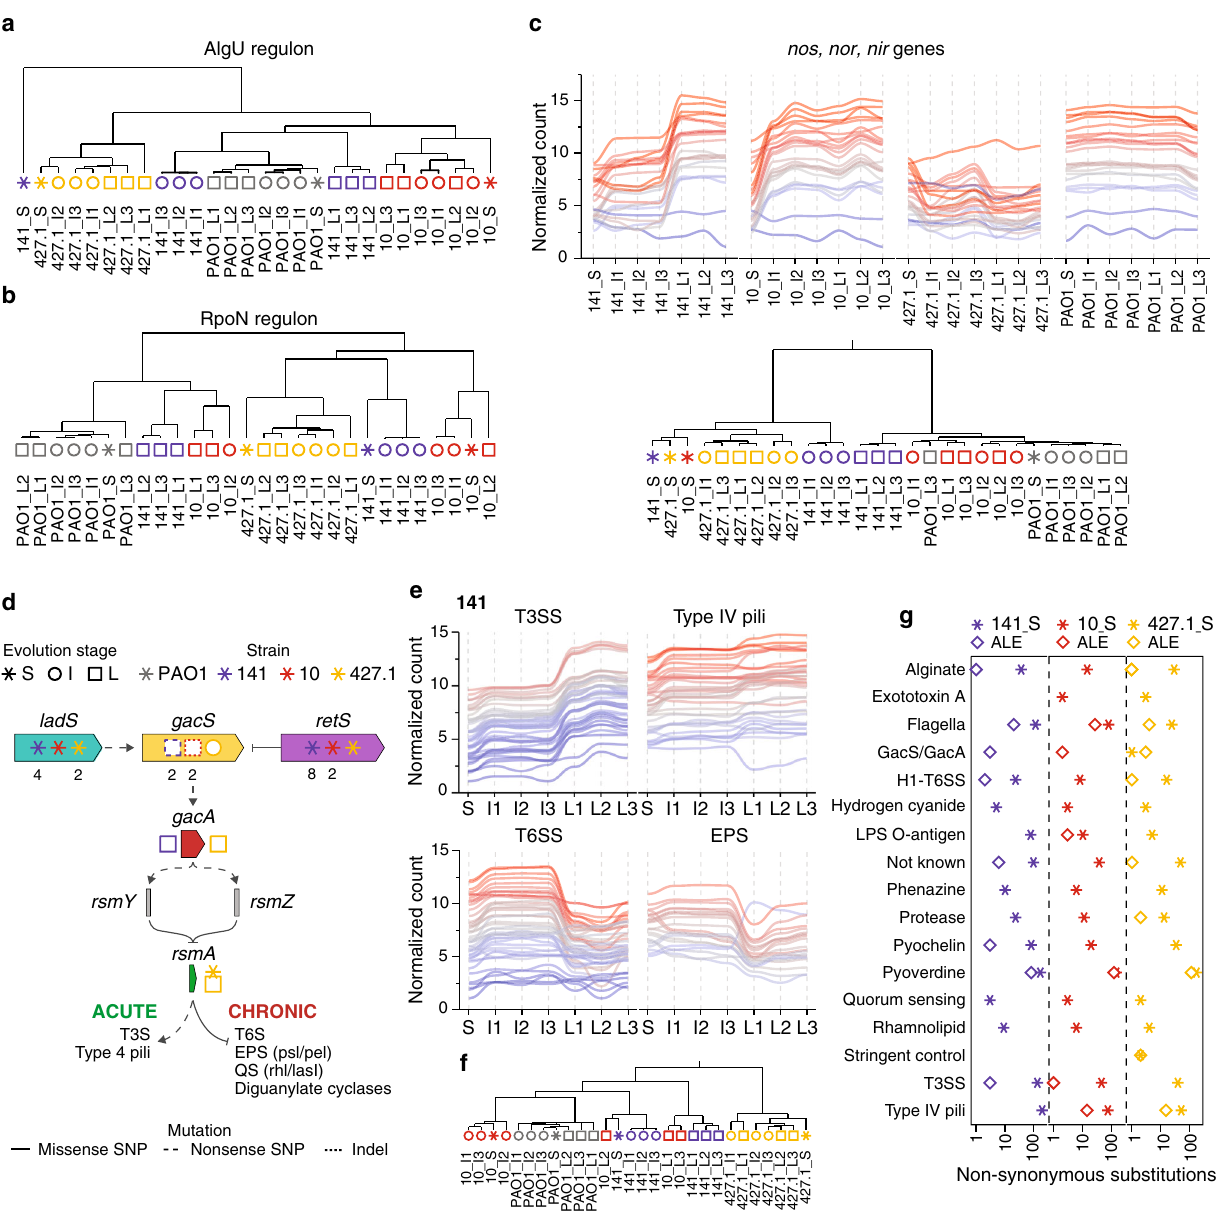
Fig. 4 Convergent mechanisms of adaptation to the ALE condition. Hierarchical clustering analysis of the evolved strains based on the expression pro fi le of genes within the a algU and b rpoN regulons. Hierarchical clustering was inferred on the Spearman correlation using the Euclidean distance. c Normalized expression pro fi le of nos , nor and nir genes in the evolved strains and clustering analysis inferred on the Spearman distance using the complete linkage method. d Schematic representation of the Gac/Rsm regulatory network along with the mutations present in the starting (S), intermediate (I) and late (L) strains. Numbers under the symbols indicate the number of mutations identi fi ed in the genes. e Normalized expression pro fi les of type 3 secretion system (T3SS), type IV pili, type 6 secretion system (T6SS) and exopolysaccharides psl and pel (EPS) genes regulated by the Gac/Rsm regulatory network in strains 141. f Hierarchical clustering analysis of the evolved strains based on the expression level of acute (T3SS and type 4 pili) and chronic (T6SS, EPS, quorum sensing (QS) and diguanylate cyclases) genes phenotypes. Clustering was inferred on the Spearman distance using the complete linkage method. g Number of non-synonymous substitutions (missense and nonsense SNPs and indel mutations) in virulence factor genes identi fi ed in the S strains (asterisk) or accumulated during the ALE (diamond). The categories were obtained from the Victors 68 , VFDB 69 and PseudoCAP 70 databases. Source data are provided as a Source Data fi